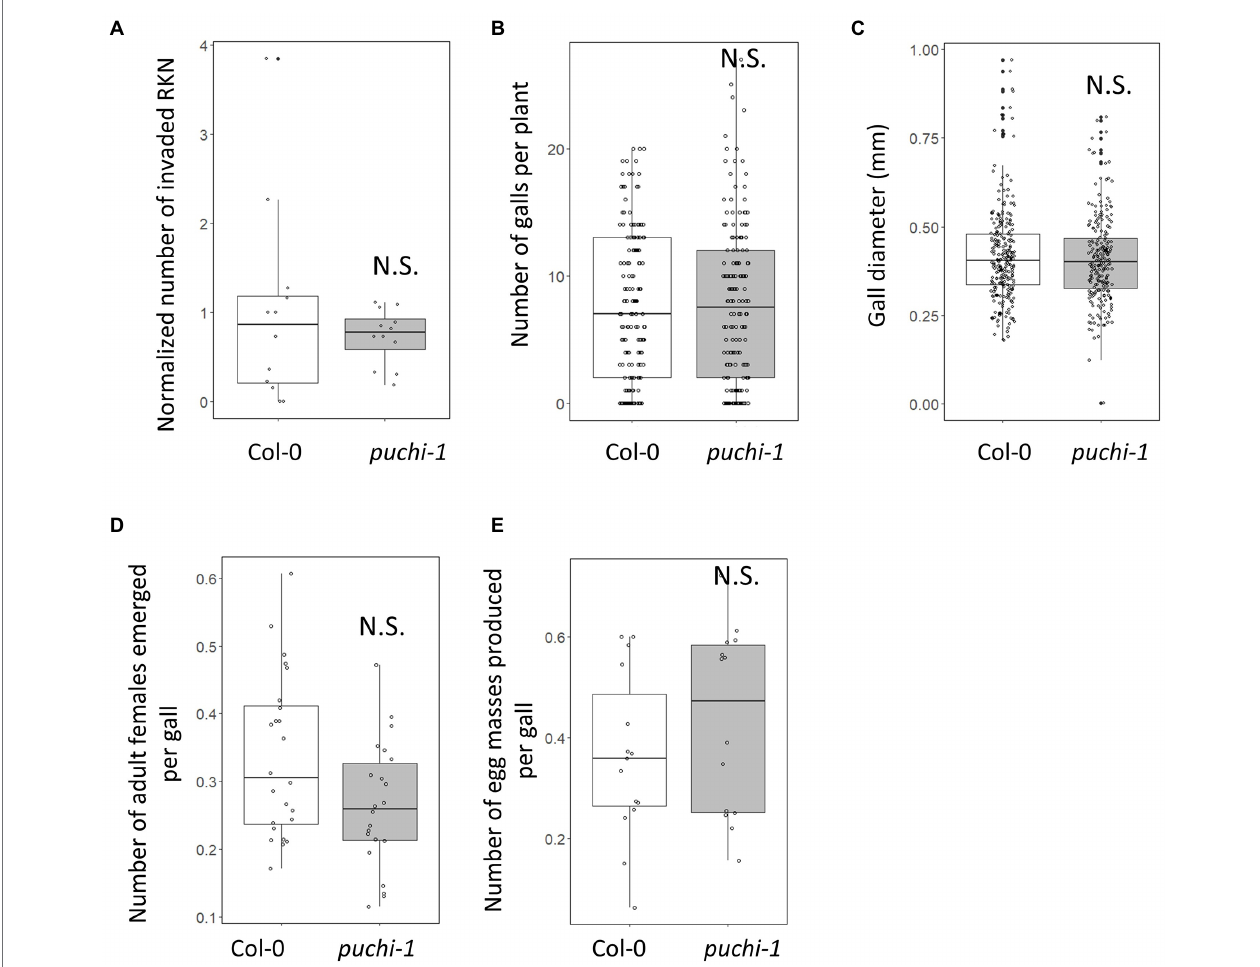
FIGURE 2 | Effect of puchi mutation during RKN infection. Numbers of invading RKNs at 2 dpi are averages from four seedlings that were then normalized to values of WT in a root (A) , galls at 14 dpi (B) , gall diameters at 14 dpi (C) , emerged mature females at 28 dpi (D) , and egg mass at 42 dpi (E) in Col-0 and puchi-1 seedlings. Values are the means of at least three biological replicates. Statistical significance was analyzed using the Brunner-Munzel test. N.S. denotes not statistically